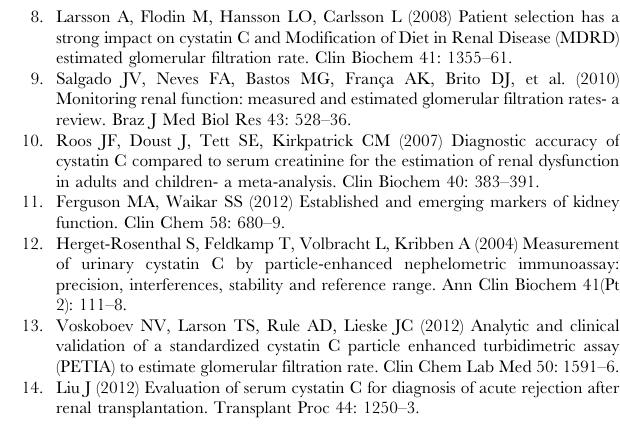
CKD1 CKD2 CKD3 CKD4 CKD5